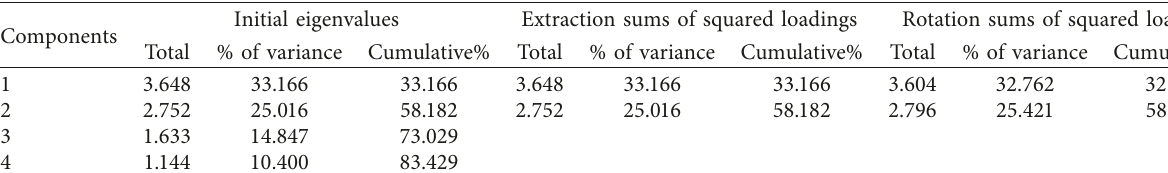
Table 6: Total variance explained.